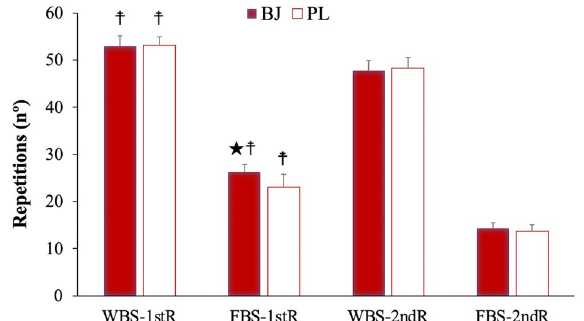
Figure 4. Repetitions completed after beetroot juice and placebo intake. Data are provided as mean and error bars as 95% confidence intervals. 1stR, first routine; 2ndR, second routine; BJ, beetroot juice; FBS, full back squat; PL, placebo; WBS, wall ball shots. ★ A significant increase in the FBS repetitions performed after BJ intake compared to PL condition in the first routine (with 3-min rest) (p = 0.004). ☨ Repetitions were